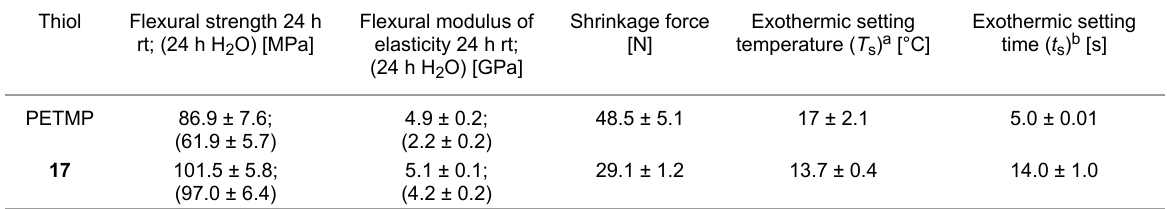
Table 2: Flexural strength and modulus of elasticity before and after storage in H 2 O, shrinkage force, exothermic setting time and exothermic setting temperature of dental composites containing 39.8 wt % organic matrix based on stoichiometric amounts of TATATO and the thiol component